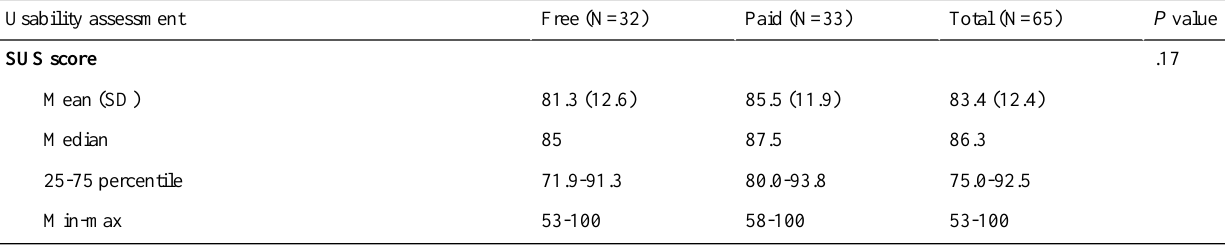
Table 8. Descriptive data for the System Usability Scale (SUS)